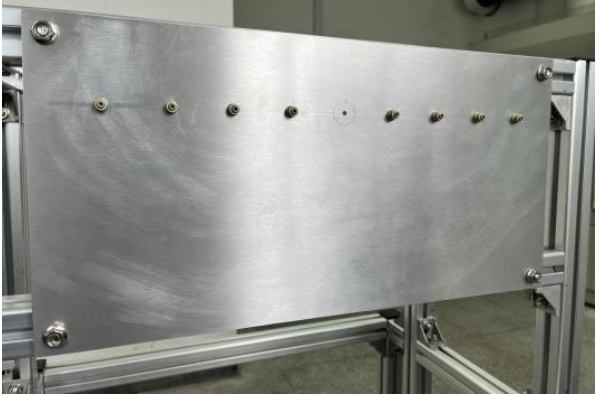
Figure 16. Specimen installed hi-lok nuts.